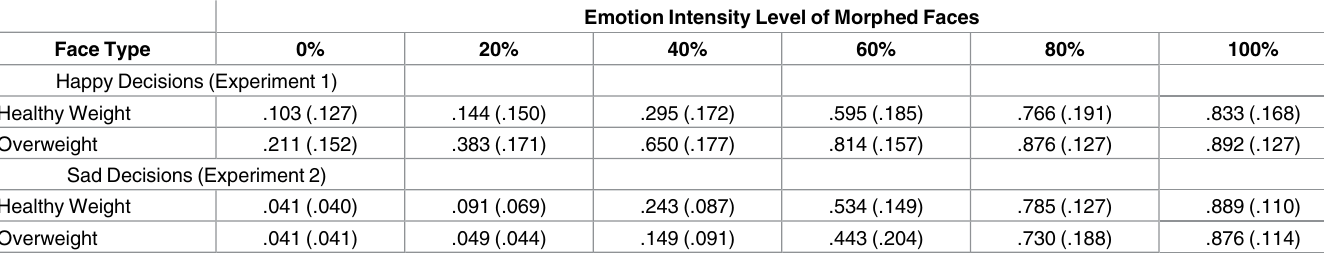
Experiment 2: neutral vs. sad) of facial stimuli was systematically examined by employing both repeated-measures ANOVAs and nonlinear psychometric curve fitting approaches. Trials in which participants failed to give a response in the time allotted (2 s) were treated as missing data and excluded from analysis. Among 960 trials, participants missed an average of 11.2 trials (1.2%) in Experiment 1, and an average of 8.0 trials (0.8%) in Experiment 2. There was no sys- tematic effect of Experiment Type, F (1,62) = 1.31, p = .26, Bodyweight Groups, F (1,62) = 0.42, p = .52, or Emotion Intensity, F (5,310) = 0.25, p = .94. For happy (Experiment 1) and sad (Experiment 2) expression judgment tasks, we separately performed 2 (Bodyweight: Healthy weight faces, Overweight faces) by 6 (Emotion Intensity: 0% ~ 100% in 20% increments) repeated-measures ANOVAs on the behavioral data of propor- tions of happy or sad decisions. Means and standard deviations are shown in Table 1. The ANOVA result on happy decisions showed a significant 2-way interaction effect of Bodyweight x Emotion Intensity, F (5,155) = 32.55, p < .001, partial η 2 = .51, as well as main effects of Table 1. Means and standard deviations of the proportion of happy and sad